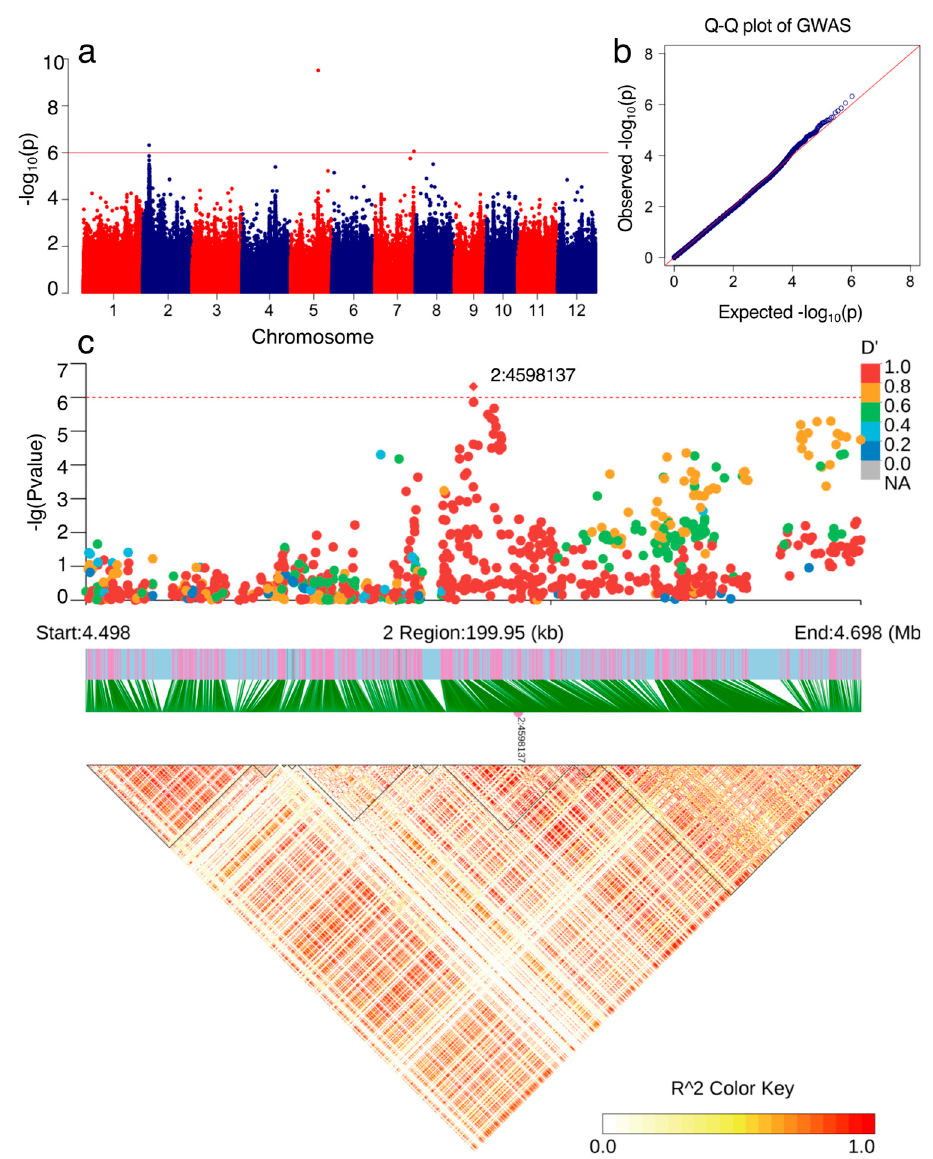
Figure 3. GWAS of NPQ(T) for the whole population in 2019. ( a ) Manhattan plot for NPQ(T). Dashed line represents the signi fi cance threshold ( − log10( P ) = 6). ( b ) Q − Q plot for NPQ(T) ( c ). Local Manhattan plot (top) and LD heatmap (bottom) surrounding the peak on chromosome 02.